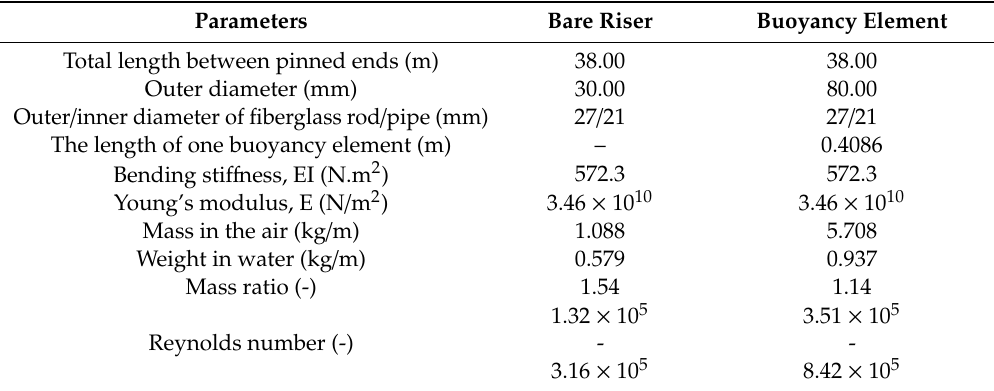
Table 7. The material properties of the bare riser section and the buoyancy element.